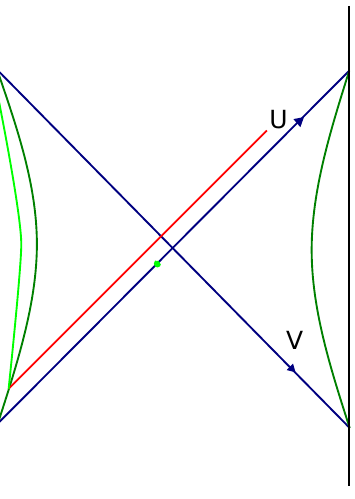
Figure 6 . The emission of a null particle back-reacts on the trajectory of the left boundary, moving the center down along the